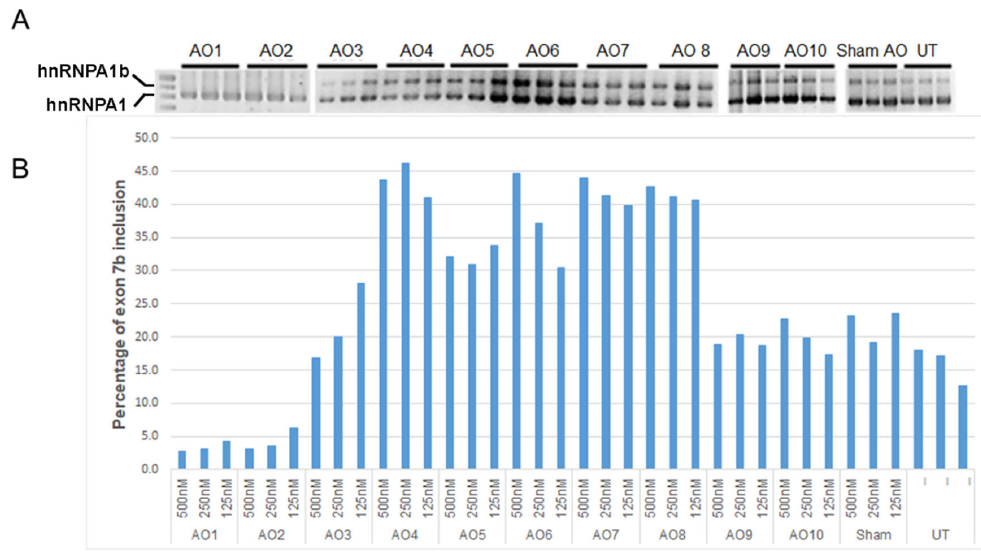
Figure 2. RT ‐ PCR analysis demonstrated splicing patterns of hnRNPA1, ( A ) and percentage of exon 7b inclusion in SMA fibroblasts transfected with different 2 ′ O ‐ methyl modified AOs ( B ).